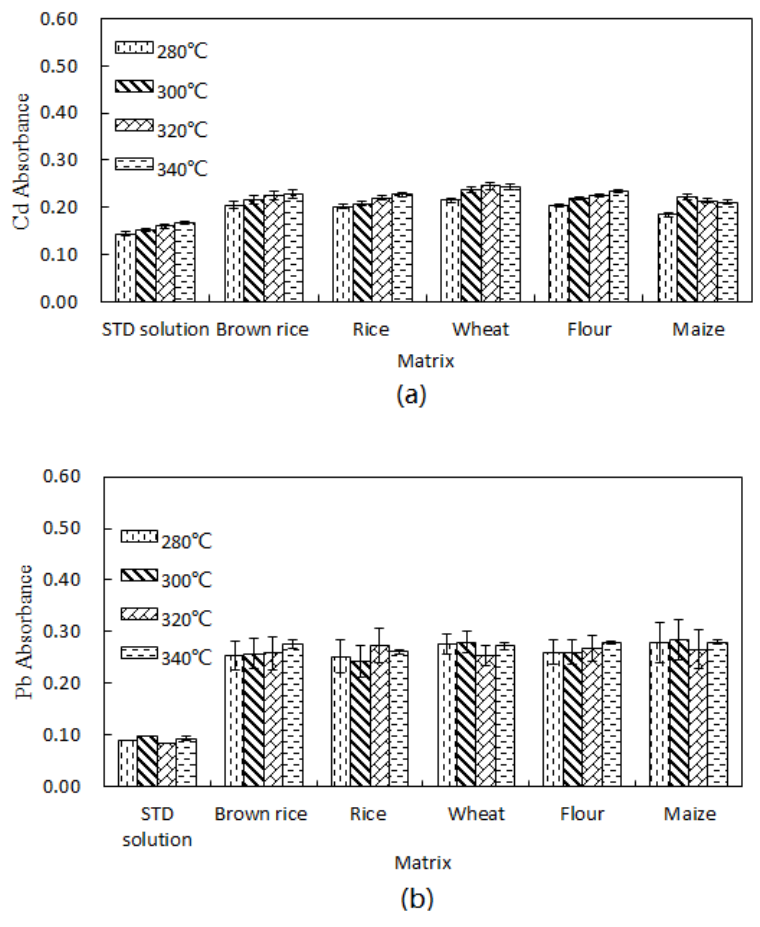
Figure 3. Effect of different pyrolysis temperatures on different grain matrices (n = 5): ( a ) Cd and ( b ) Pb.